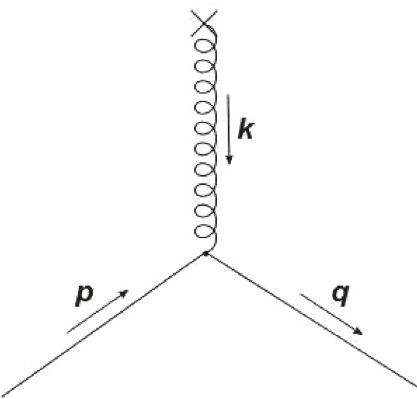
Figure 4: Diagram for the interaction of a fermion with an external weak gravitational